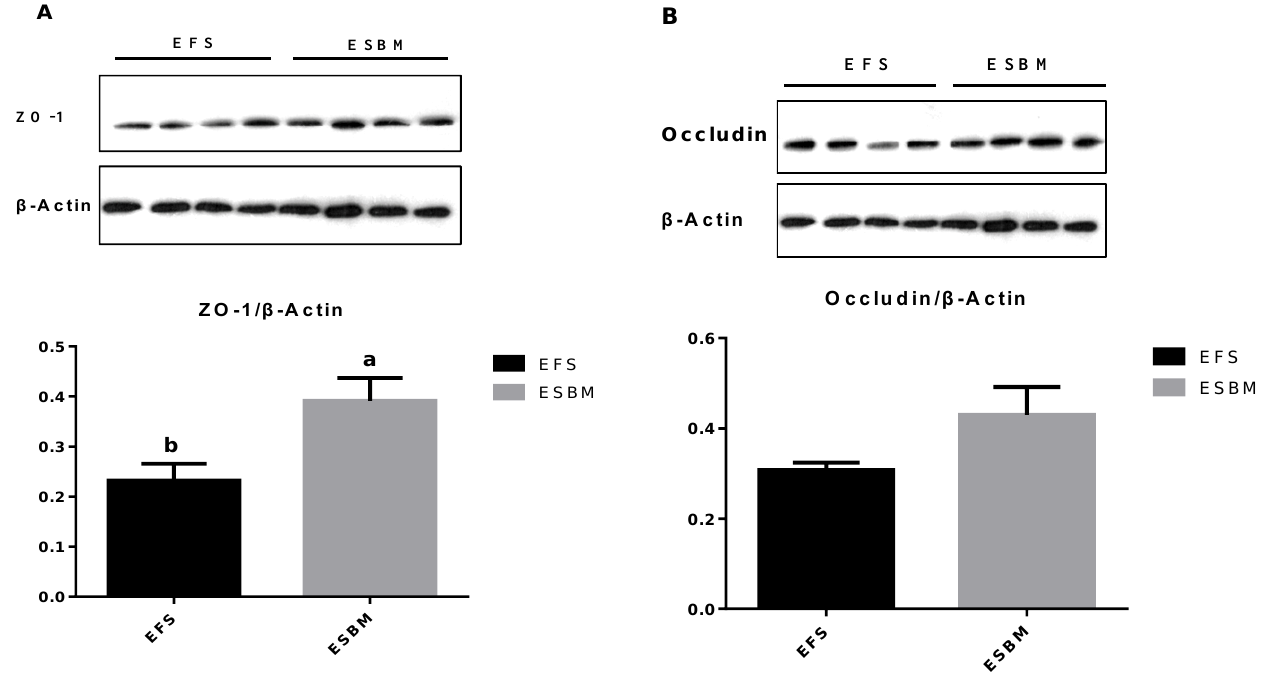
Figure 1. Effects of enzyme-treated soybean meal replacing extruded full-fat soybean on protein expression of ZO-1 ( A ) and occludin ( B ) in jejunal mucosa in nursery pigs. n = 8. EFS: Extruded full-fat soybean; ESBM: Enzyme-treated SBM. a,b Different letters indicate a significant difference ( p < 0.05). (original Western blot figures are in Figure